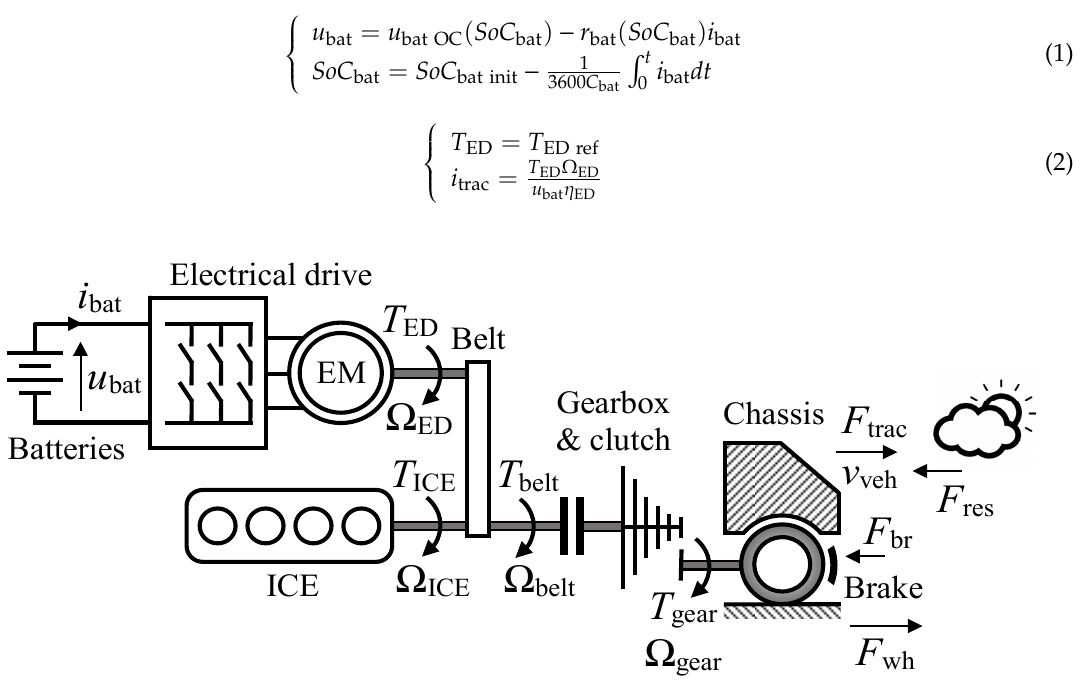
Figure 1. Studied system: a parallel hybrid truck.